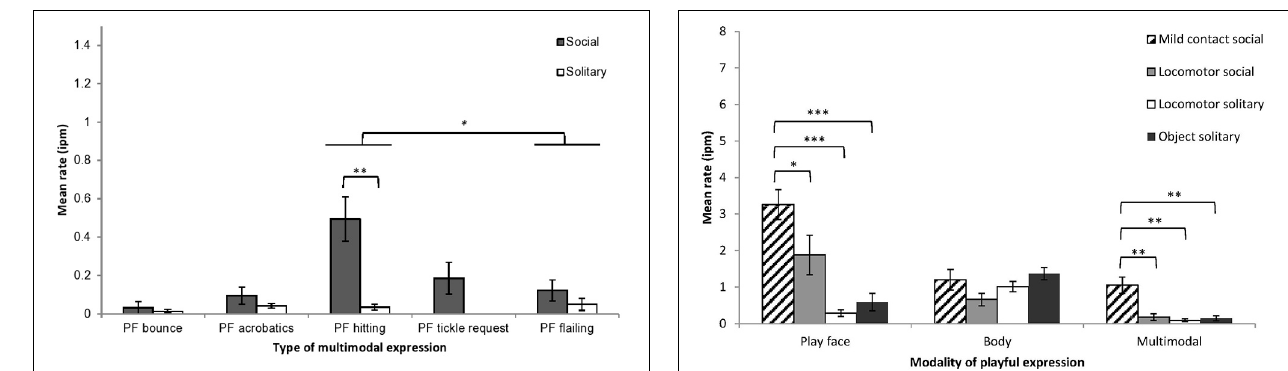
FIGURE 4 | Mean rates (intervals per minute of play, with SE) of chimpanzee infants’ playful expressions by modality (play face, body, multimodal) and by sub-types of social and solitary play. Simple contrasts in One-Way ANOVA were conducted to compare expression rate during mild contact social play with the other three sub-types of play, for each modality of expression. ∗ p < 0 . 05, ∗∗ p < 0 . 01, ∗∗∗ p < 0 .